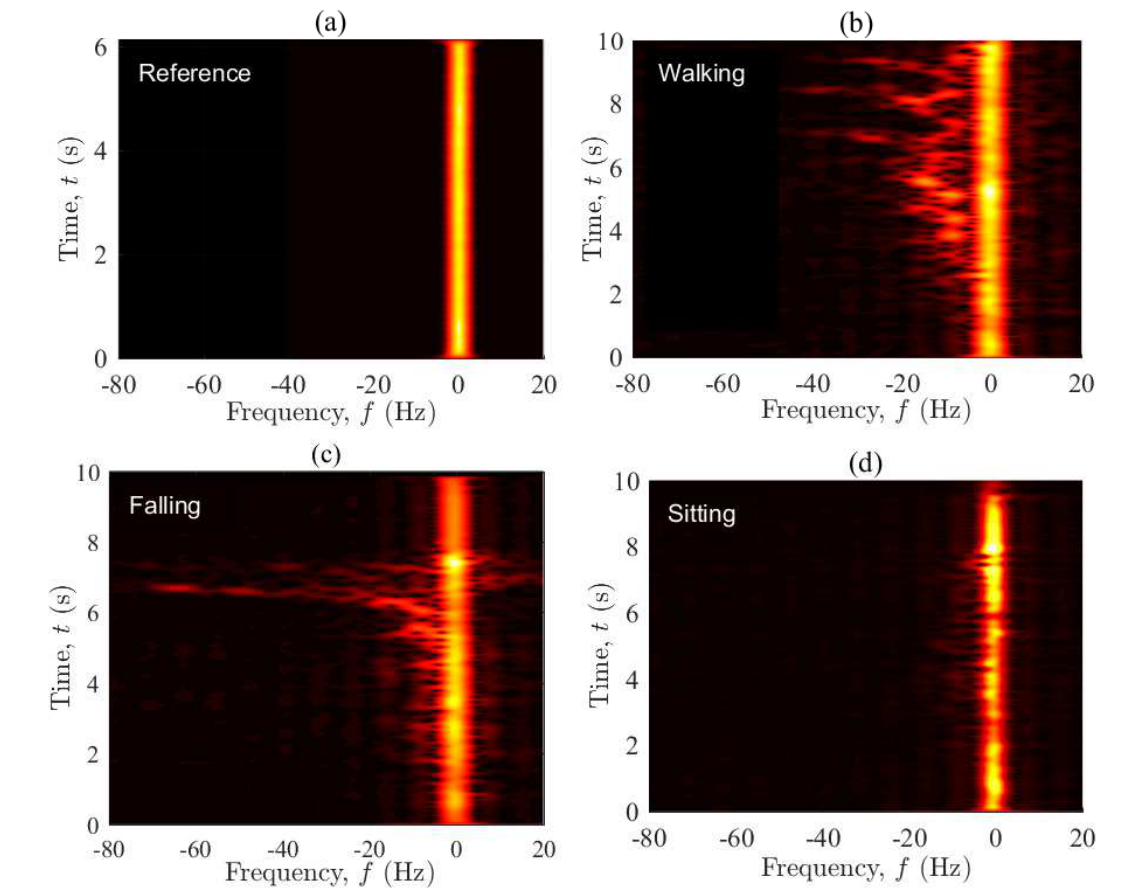
Figure 8. The spectrogram S (cid:63) xx ( f , t ) of the complex channel gain µ (cid:63) ( t ) for the four scenarios in S2: ( a ) reference, ( b ) walking, ( c ) falling, and ( d )